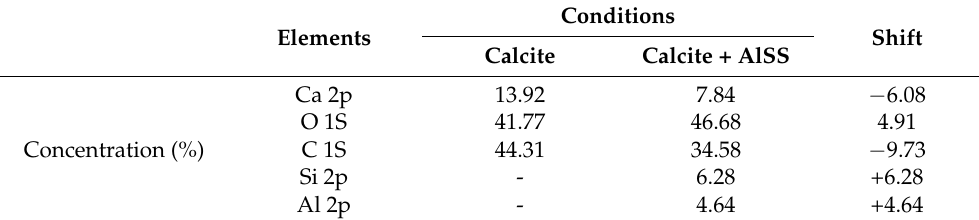
Table 2. Atomic concentrations and the shifts of elements on the calcite surface.